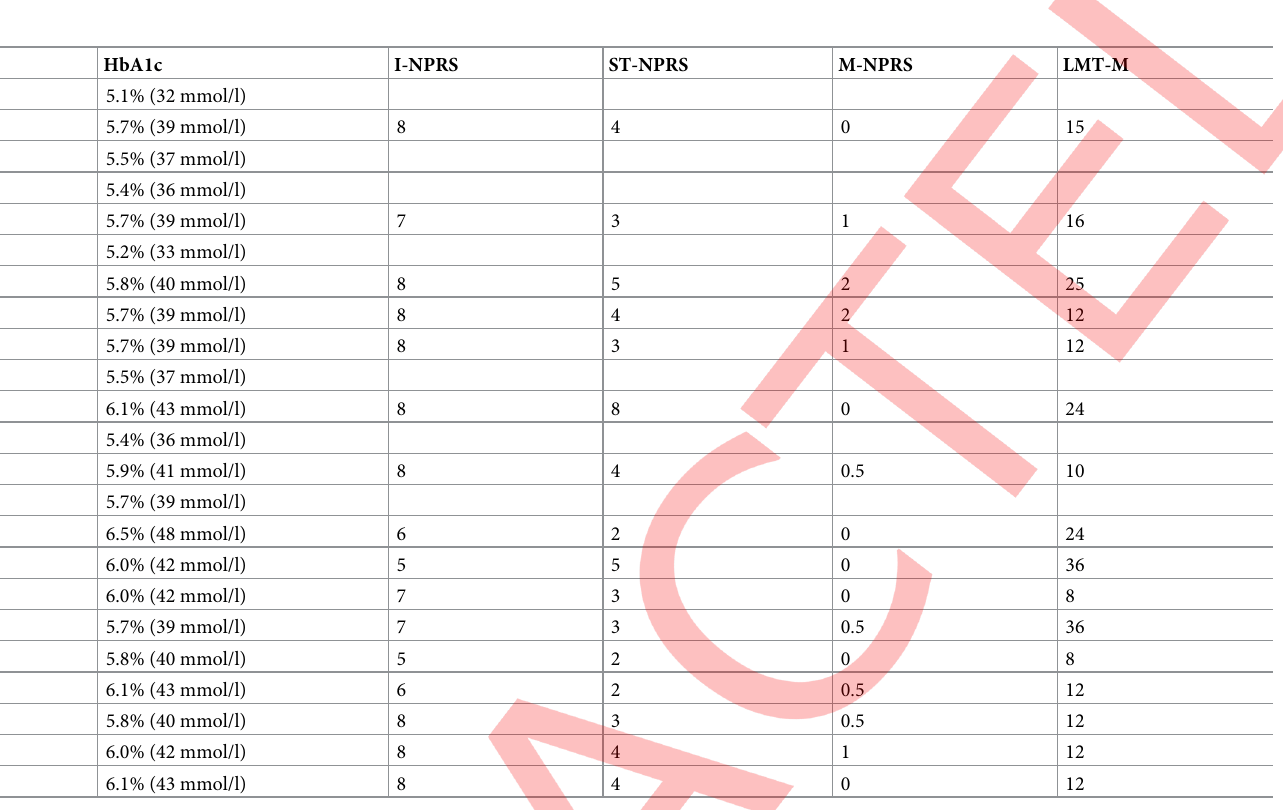
Depicted are individual patients’ age, HbA1c % with corresponding mmol/l between parenthesis, pain scores at initial encounter (I-NPRS), pain scores after standard treatment (ST-NPRS), pain scores after metformin treatment (M-NPRS) and length of metformin treatment in months (LMT-M). Patients retained the therapeutic effect of metformin at the time of their last clinical encounter as indicated in